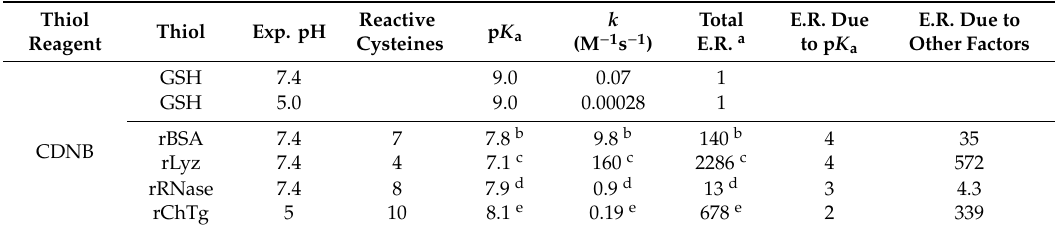
Table 1. Enhanced reactivity and analytical data for the reaction of several thiol reagents with the four reduced proteins in their molten globule-like